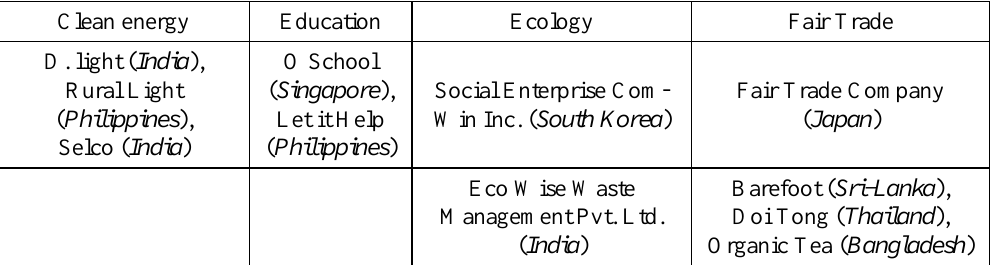
Table 1. List of Major Social Enterprises in South Asia (created by the authors) Clean